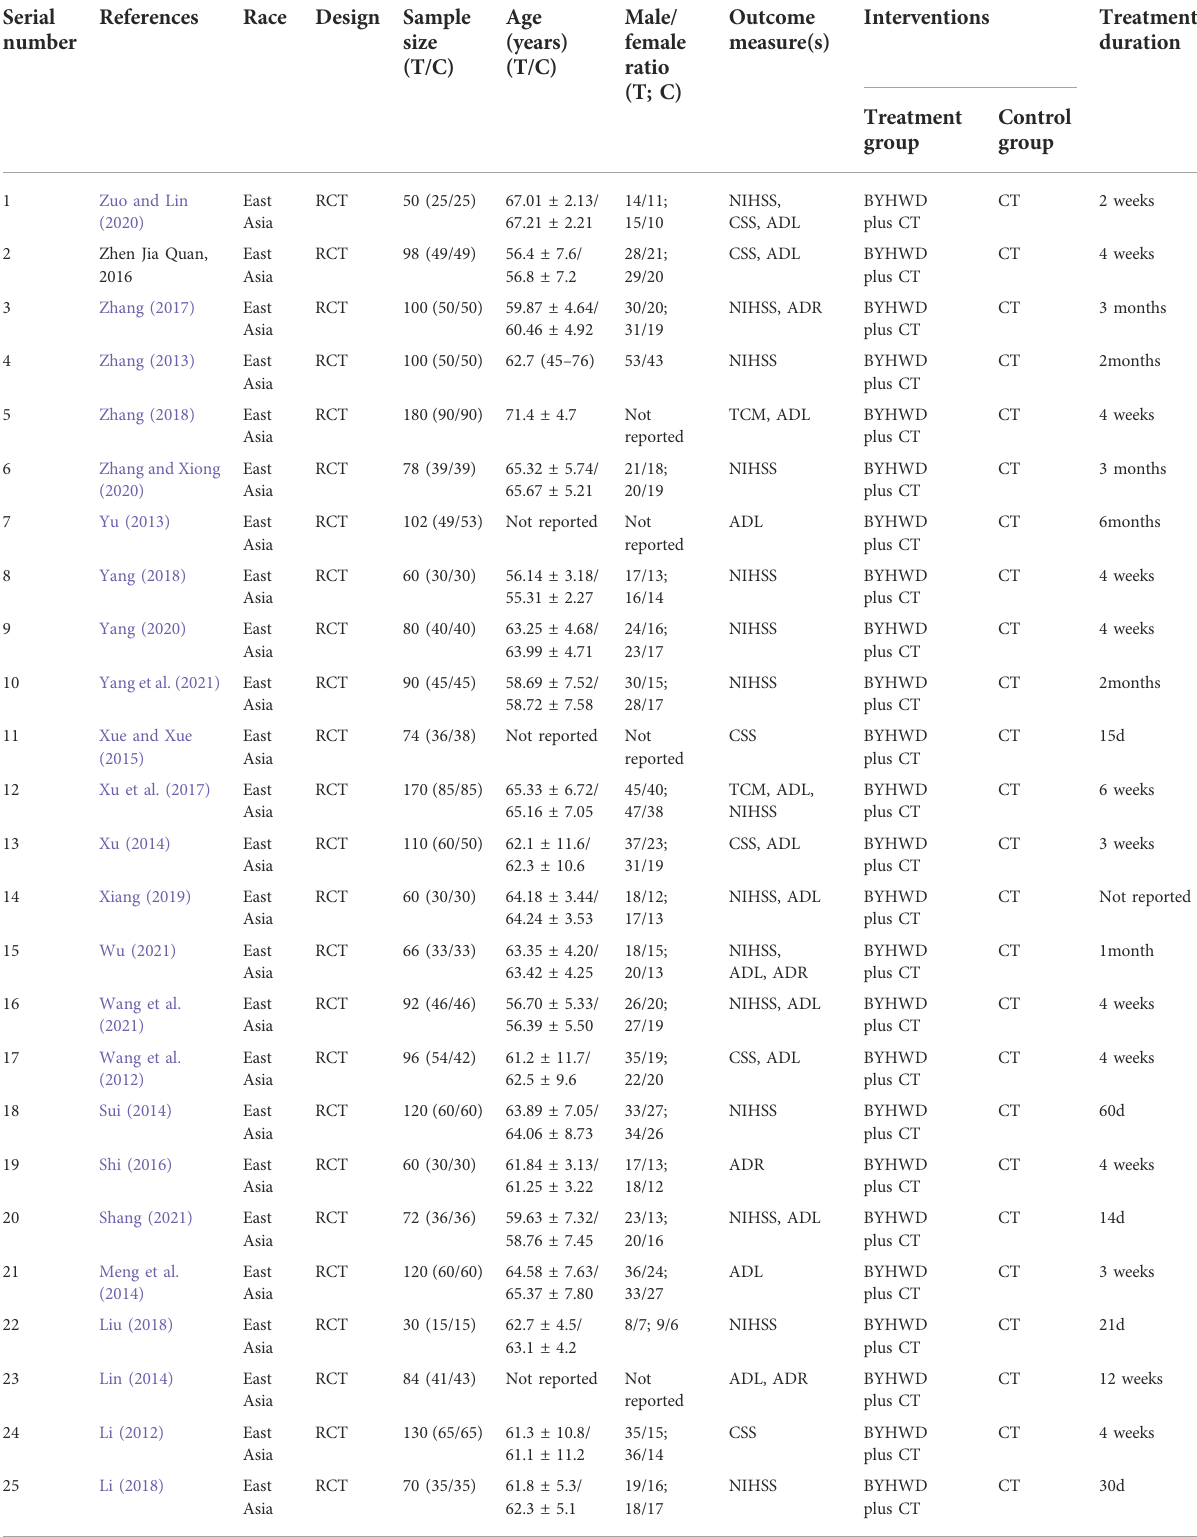
TABLE 2 Characteristics of studies included in the